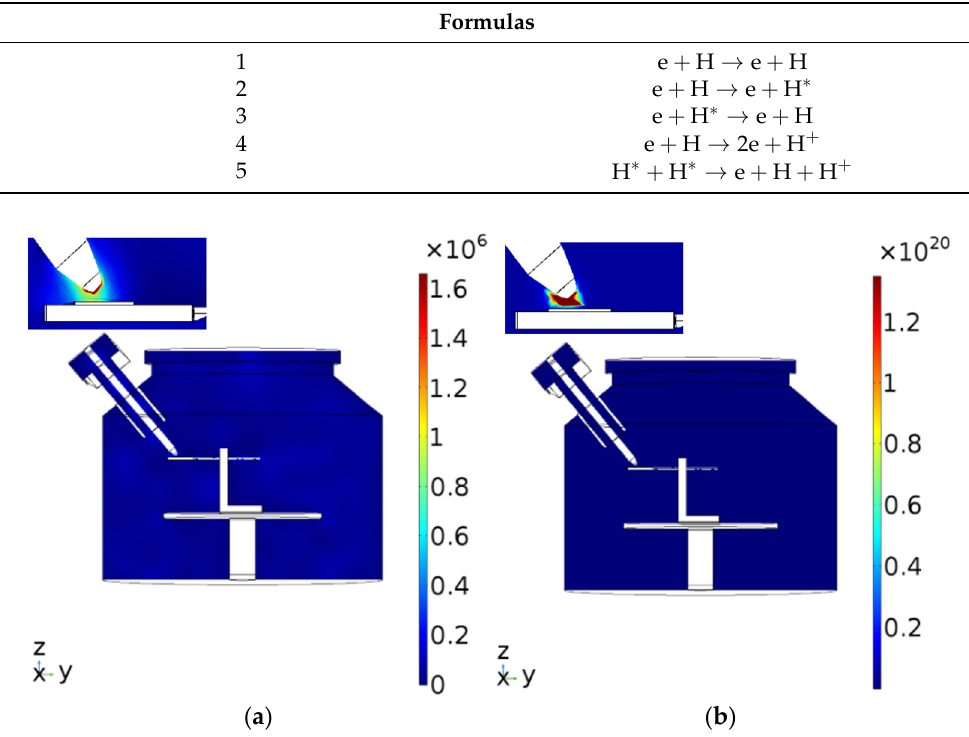
Figure 7. Electron density of the argon plasma as a function of microwave power level for gas pressures of ( a ) 5 Torr, ( b ) 35 Torr, ( c ) 70 Torr, and ( d ) 90 Torr.